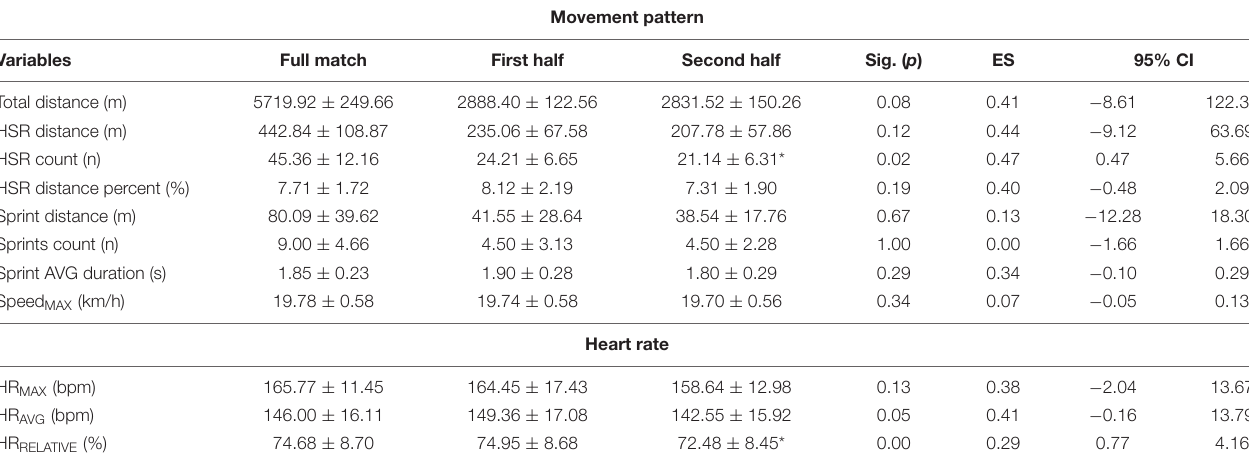
TABLE 1 | Movement pattern and heart rate demands of referees during match.